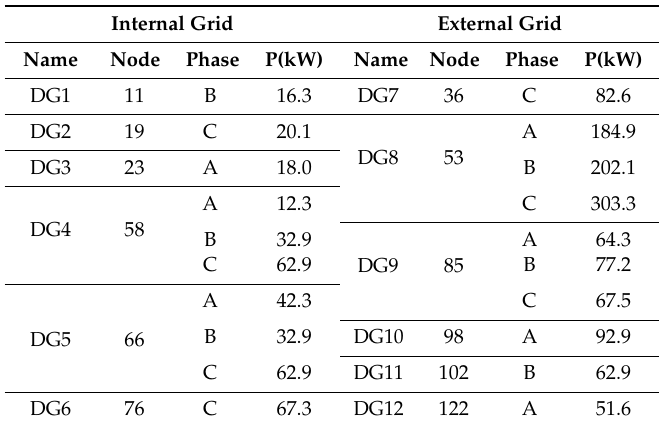
Table 2. DG information in Case